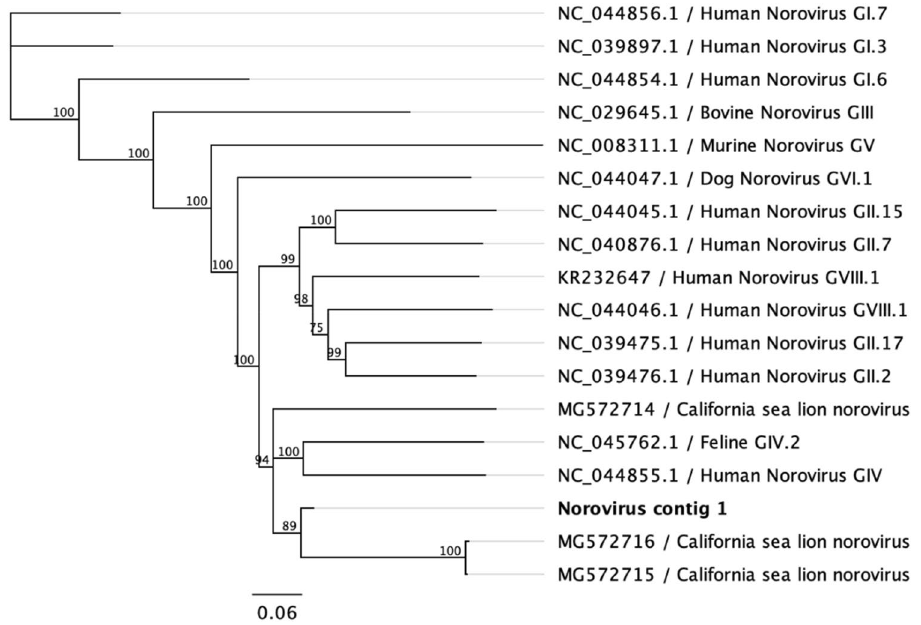
Figure 5. Phylogenetic consensus tree of the Norovirus contig sequenced from A. gazella scats (in bold). Bootstrap resampling with 1000